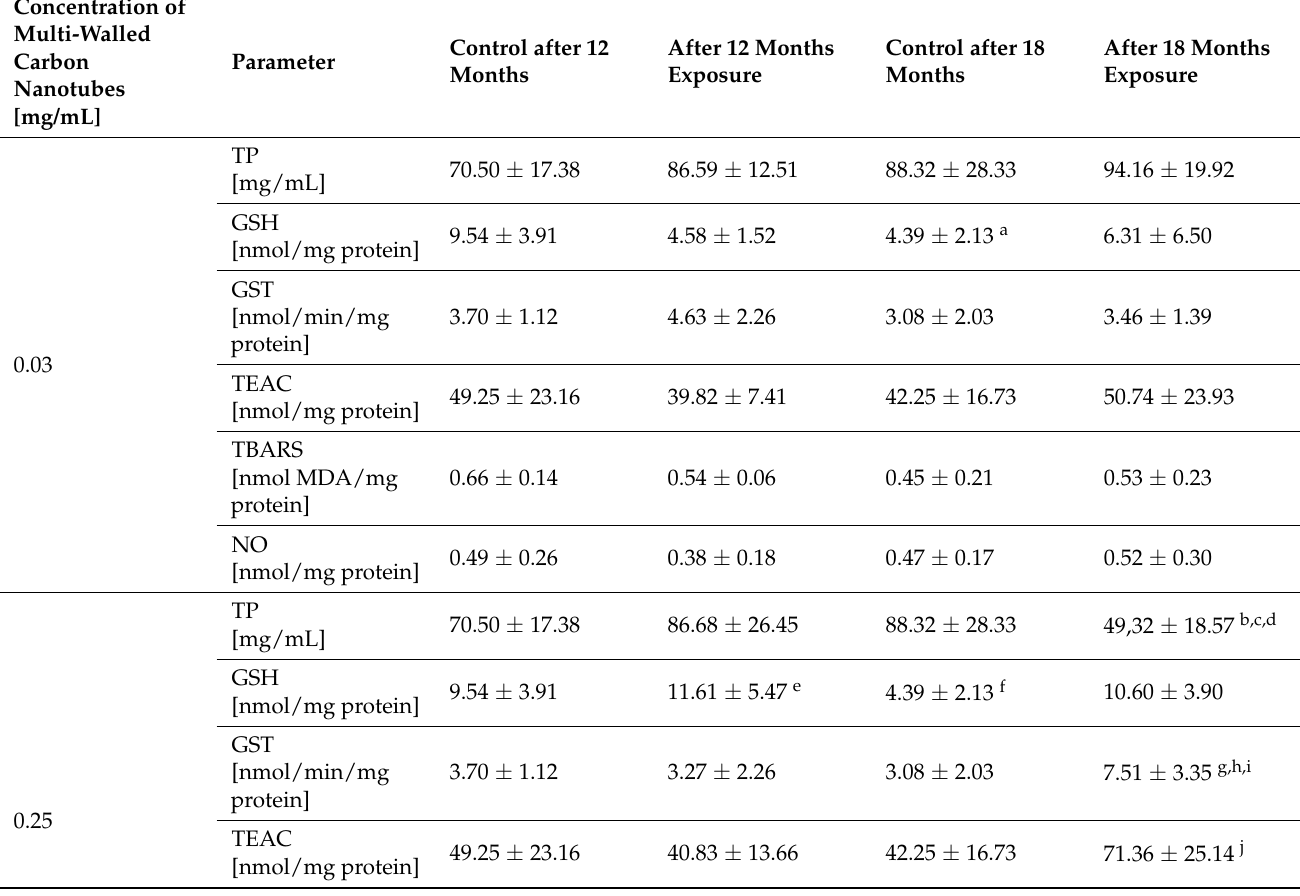
Table 1. Concentration of selected parameters of oxidative stress in serum in animals exposed to multi-walled carbon nanotubes after 12 and 18 months. (a)—statistically significant difference for control group at 18 months versus control at 12 months ( p = 0.040649); (b)—statistically significant dif- ference in group receiving MWCNTs in concentration of 0.25 mg/mL versus 0.03 mg/mL ( p = 0.09144); (c)—statistically significant difference in group receiving MWCNTs in concentration of 0.5 mg/mL versus 0.25 mg/mL ( p = 0.01629); (d)—statistically significant difference in group receiving MWCNTs in concentration of 0.25 mg/mL versus control group ( p = 0.02529); (e)—statistically significant differ- ence in group receiving MWCNTs in concentration of 0.25 mg/mL versus 0.03 mg/mL ( p = 0.017977); (f)—statistically significant difference in group receiving MWCNTs in concentration of 0.5 mg/mL ver- sus 0.25 mg/mL ( p = 0.014816); (g)— statistically significant difference in group receiving MWCNTs in concentration of 0.25 mg/mL versus 0.03 mg/mL ( p = 0.031157); (h)—statistically significant differ- ence in group receiving MWCNTs in concentration of 0.25 mg/mL versus control group ( p = 0.016943); (i)—statistically significant difference in group receiving MWCNTs in concentration of 0.25 mg/mL at 18 months versus 12 months ( p = 0.027652); (j)—statistically significant difference in group re- ceiving MWCNTs in concentration of 0.25 mg/mL at 18 months versus 12 months ( p = 0.025886); (k)—statistically significant difference in group receiving MWCNTs in concentration of 0.5 mg/mL versus control group ( p = 0.029093); (l)—statistically significant difference in group receiving MWC- NTs in concentration of 0.5 mg/mL versus 0.25 mg/mL ( p = 0.01629); (m)—statistically signifi- cant difference in group receiving MWCNTs in concentration of 0.5 mg/mL versus 0.25 mg/mL ( p = 0.014816); (n)—statistically significant difference for control group at 18 months versus control at 12 months ( p = 0.040649); (o)—statistically significant difference in group receiving MWCNTs